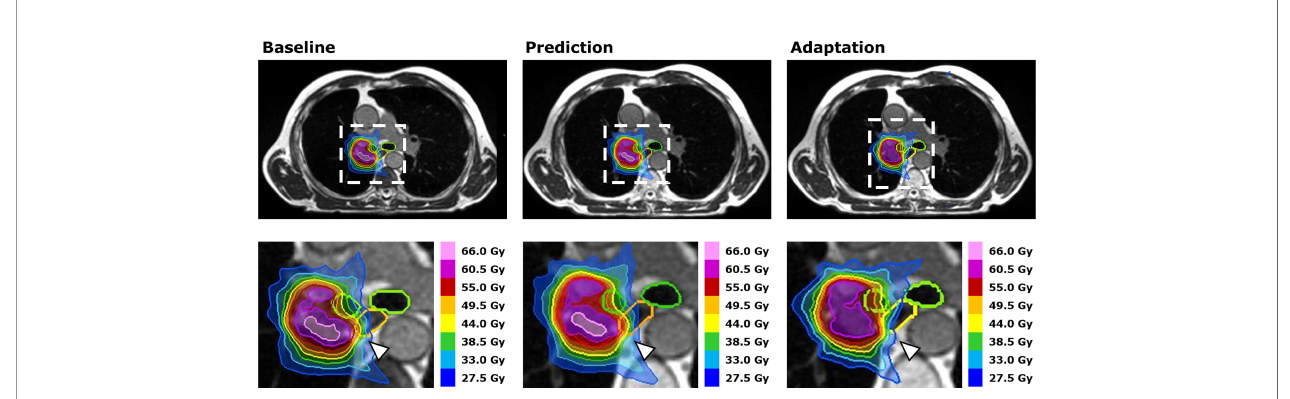
FIGURE 4 | Case Study. Dose distributions for dose intensi fi ed SBRT (10 × 5.5 Gy) of an ultracentral lung tumor adjacent to the right main stem bronchus at baseline (left), after plan prediction (middle) and after plan adaptation (right). Segmentations of the proximal bronchial tree (green) and the esophagus (orange) demonstrate a shift of the esophagus into the high dose volume after plan prediction. This led to a violation of the esophageal dose constraint, which was remedied successfully by plan adaptation